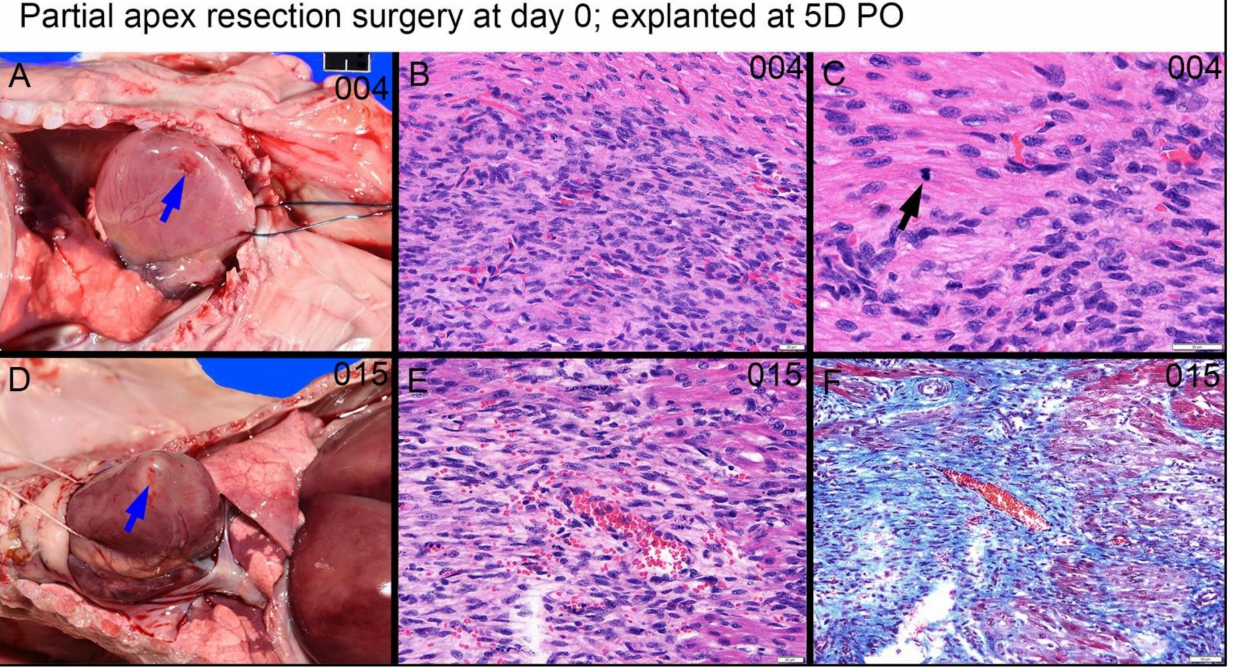
Figure 12. Partial apex resection surgery at 0 days and heart explanted at 5D PO ( A – C )—( A ) Gross necropsy heart obtained five days post-operation (5D PO) from piglet #004. Note partially filled surgical defect (blue arrow) (Scale bar = 1 cm). ( B ) Hematoxylin and Eosin (H & E) histology (piglet #004) reveals a densely packed population of streaming cells in register with peripheral myocardium and with similar slightly larger elongate often plump nuclei (Scale bar = 20 µ m). ( C ) H & E histology (piglet #004) of the marginal zone of proliferative cells has a mitotic figure of a cell identifiable as a cardiomyocyte based on straplike morphology, eosinophilic cytoplasm, and cross striations (black arrows) (Scale bar = 20 µ m). Partial apex resection surgery at 0 days and heart explanted at 5D PO ( D – F )—( D ) Gross necropsy heart obtained five days post-operation (5D PO) from piglet #015. Note partially filled surgical defect (blue arrow) (Scale bar = 1 cm). ( E ) H & E histology (piglet #015) reveals a population of similar streaming elongate cells with elongate nuclei. ( F ) Masson’s trichrome stain (piglet #015) reveals a moderate intervening collagenous